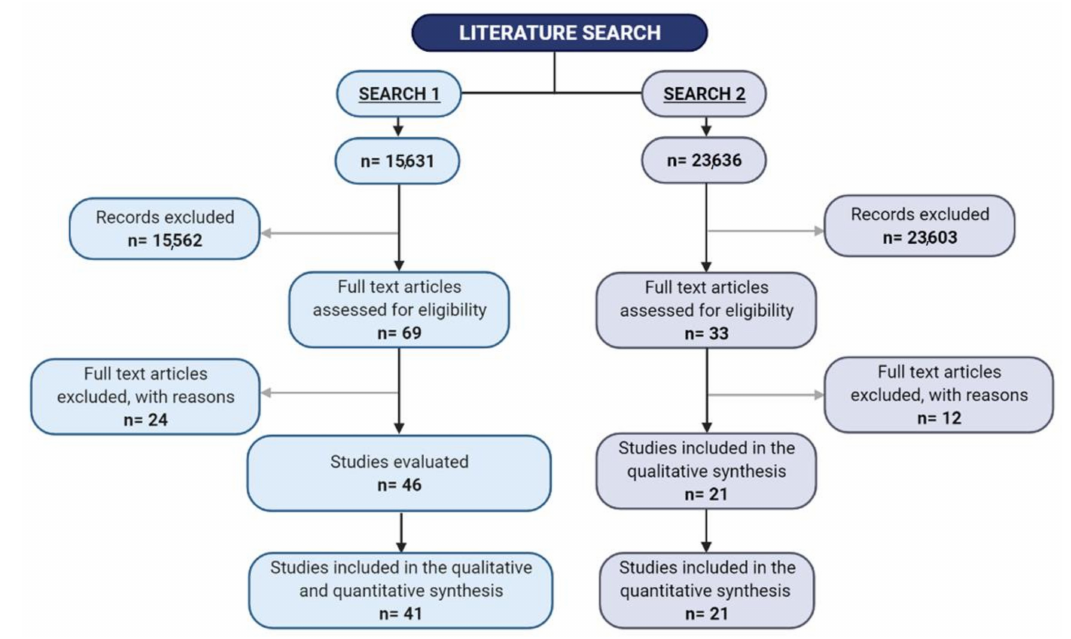
Figure 1. Study flow chart. Table 1. Characteristics of studies detected with the first literature